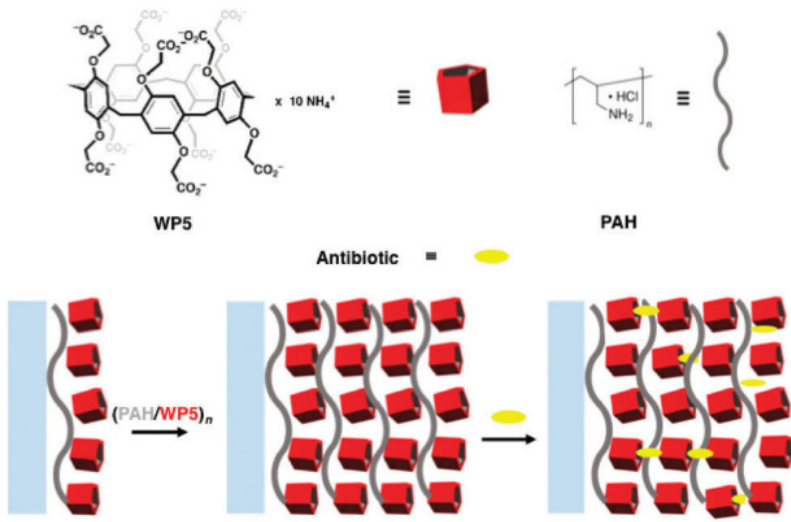
Figure 1. The formation of “ WP5 –antibiotic” inclusion complexes. Reproduced with the permis- sion of reference [67]. Copyright © Royal Society of Chemistry 2018.